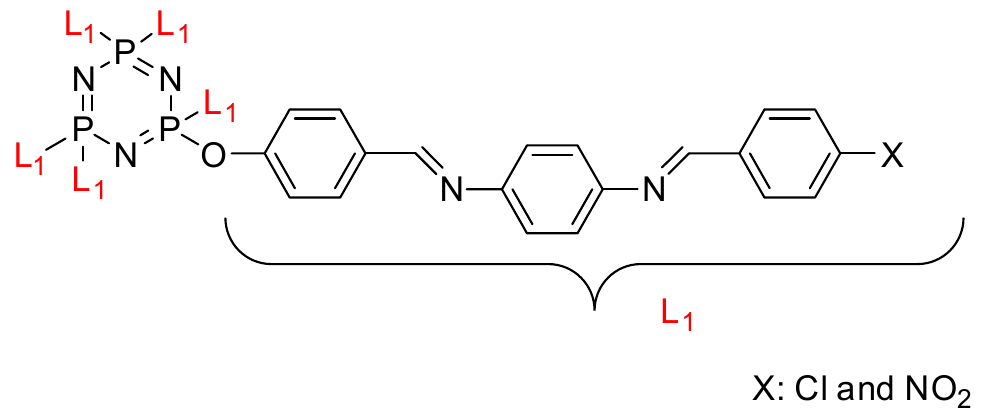
Figure 3. Hexasubstituted cyclotriphosphazene with two Schiff base linking units .